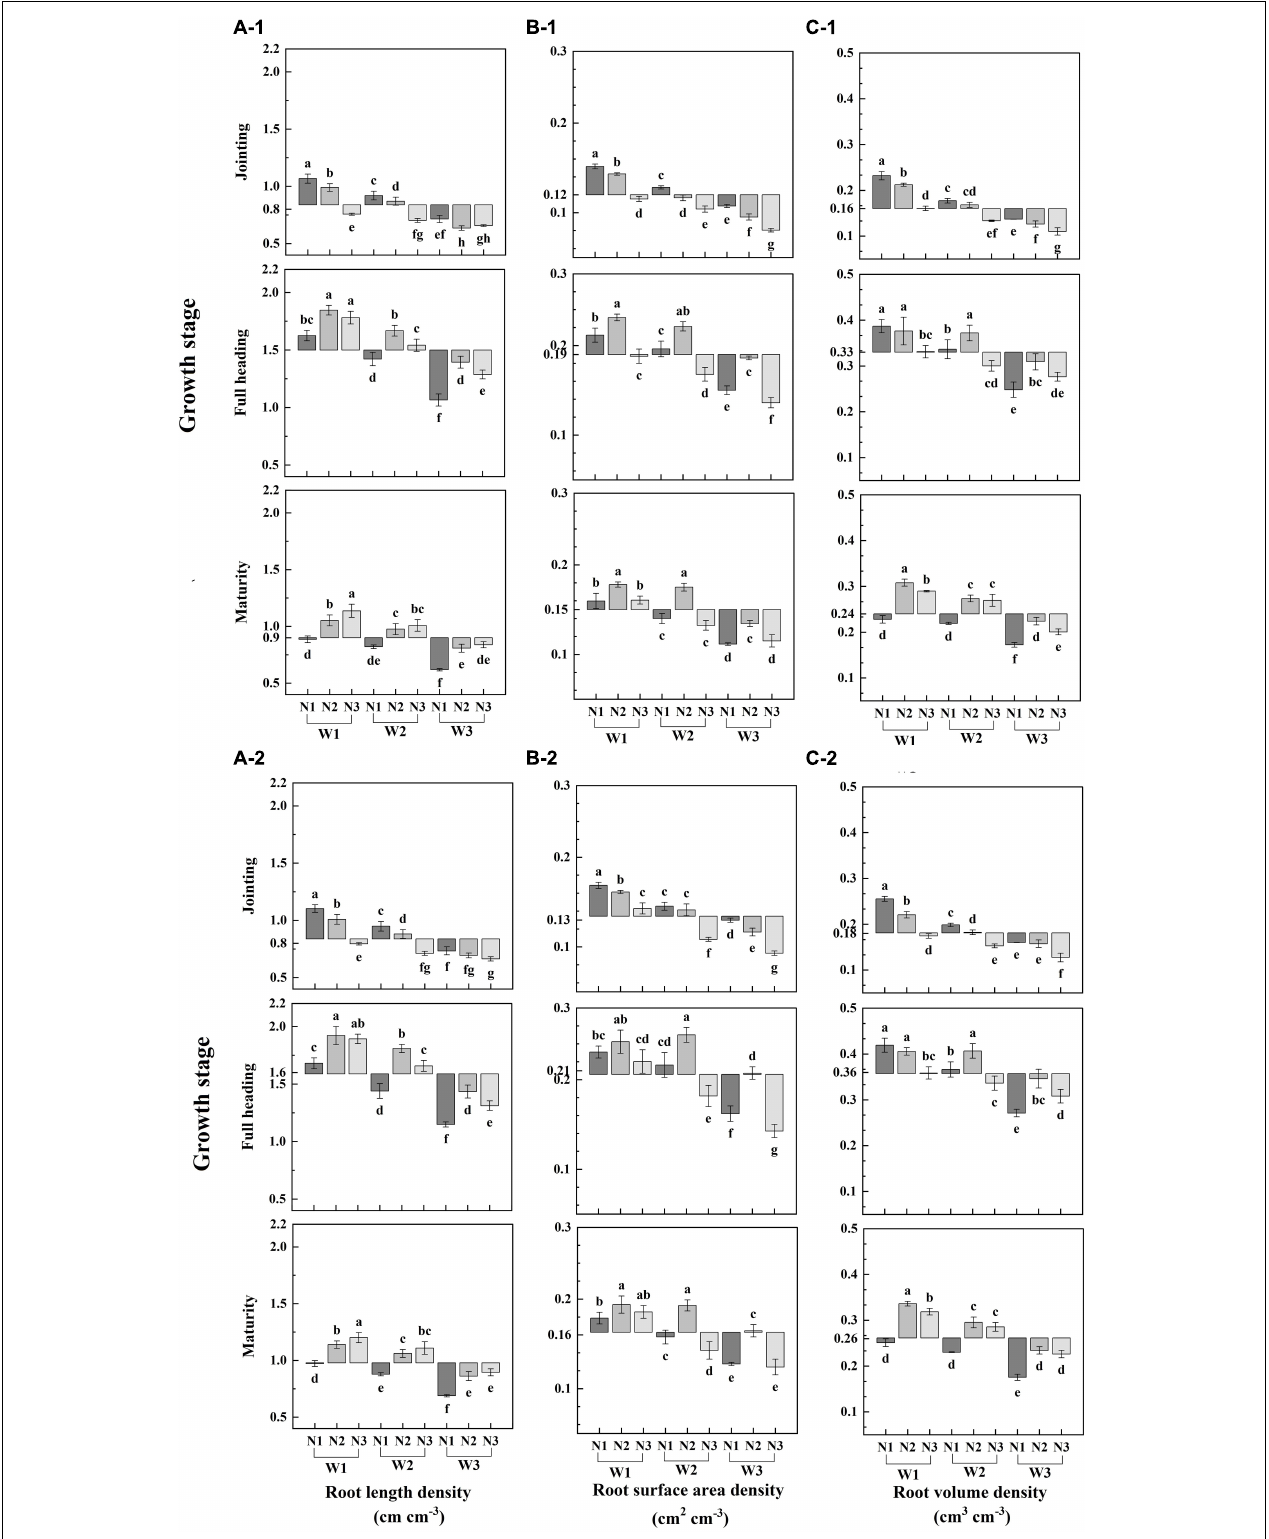
FIGURE 1 | Effect of the irrigation methods and N split applications on total root length density, root surface area density and root volume density ( A–1,2, B–1,2, C–1,2 , in 2019 and 2020, respectively). Shown are the means values ( n = 3). Values of different letters are significantly different at P < 0.05.